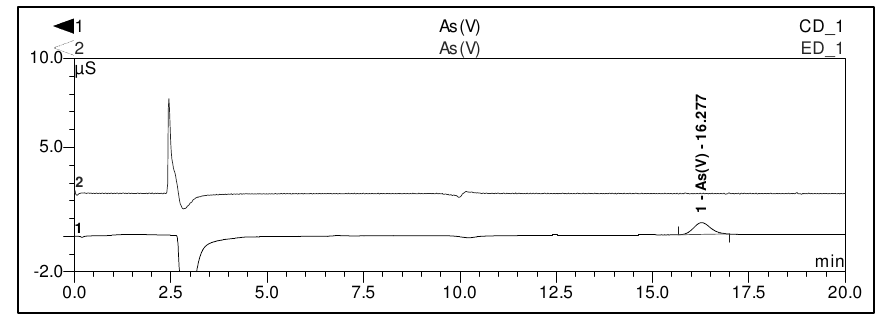
Figure 2. Conductivity detection of arsenate ( Peak of arsenate was detected on conductivity channel without any Interference. At the same time, no peak of arsenite and arsenate was detected on amperometry channel ).